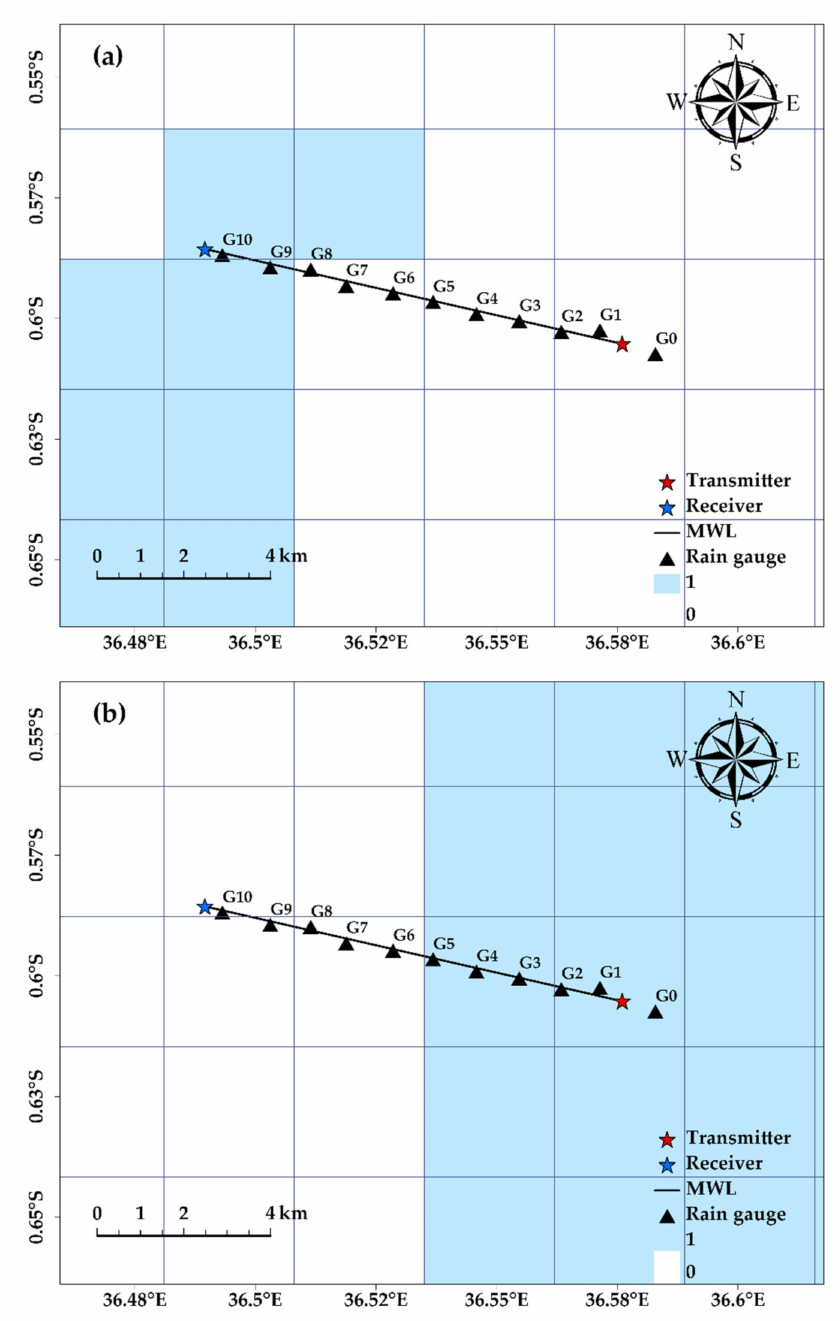
Figure 2. Rain area detection over the MWL and wpl for different wet periods. ( a ) Rain areas covering approximately 20% of the MWL length ( b ) Rain areas covering approximately 50% of the MWL length The Blue (1) areas show raining areas and the white (0) are dry areas detected by the MSG-based rain area